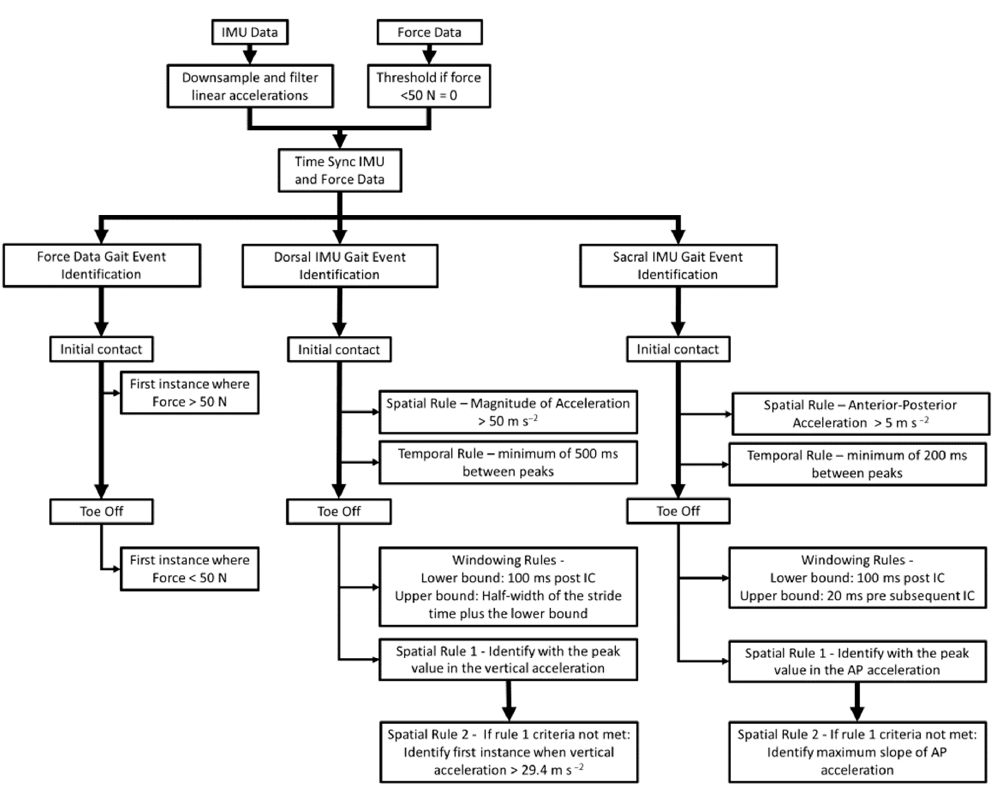
Figure 1. Flow chart of the data postprocessing steps and the algorithmic methods for the identification of gait events from the force-sensing insole data, and data from multi-axial IMUs at both anatomical locations.